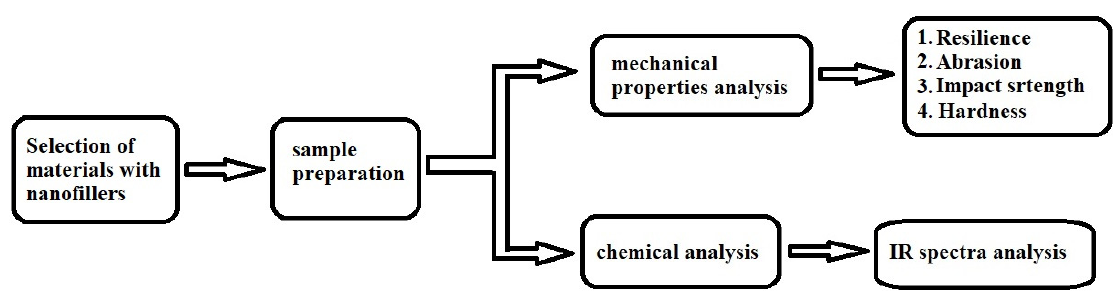
Figure 1. Flowchart of process flow.